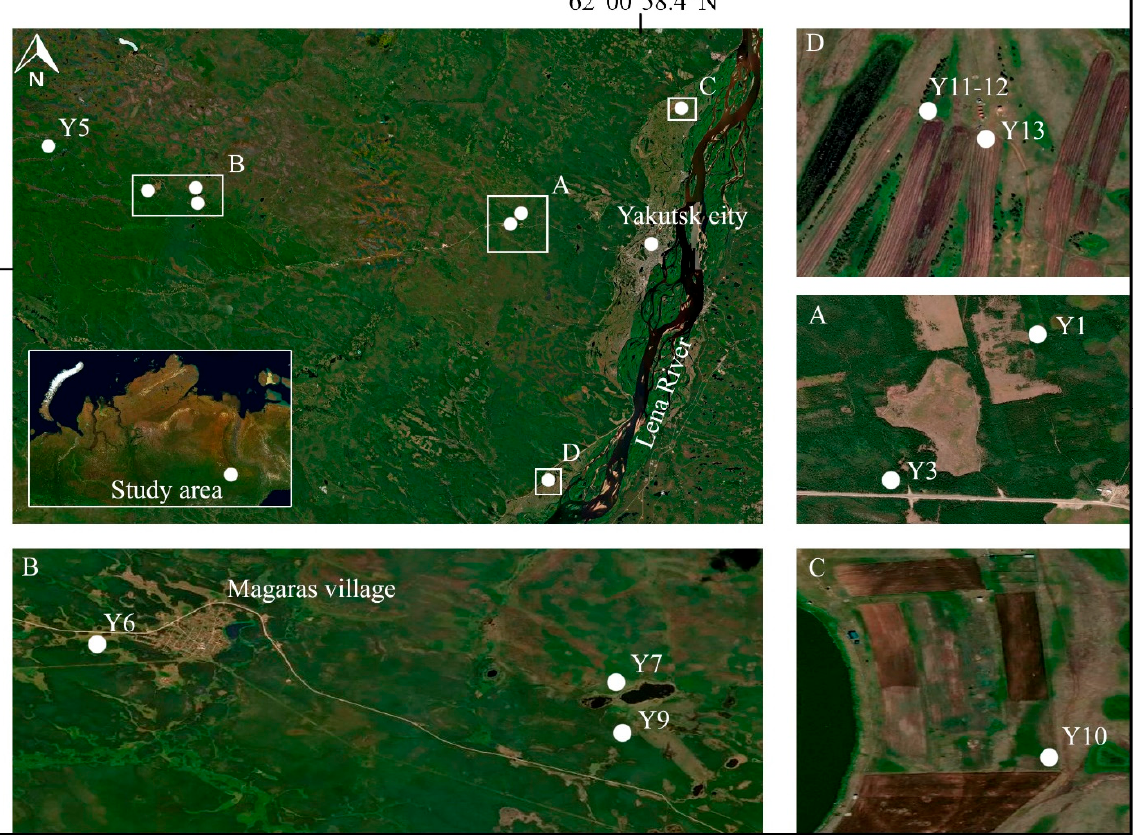
Figure 1. Study area of fallow, pyrogenic and arable soils in the vicinity of Yakutsk ( A – D ). During the study, powerful fires acted in the region, and soils were also selected in areas that were exposed to fire in order to analyze the effect of ground fires on the microstructure of the soil profile. The main criterion in selecting research objects was the coverage of different areas exposed to agriculture in the past and present times. Thus, Y1 is a fallow soil, on which zonal processes of soil formation have been taking place for a long time. The background object, Y3, which has not been exposed to anthropogenic load, was chosen for this site. To study the process of influence of forest fires on micromorphological characteristics of soil, we studied the soil subjected to wildfire (Y5). Near Magaras village, three objects were studied: soil used for cattle grazing (Y6), soil used for haying (Y7), as well as background soil (Y9). To study the micromorphological characteristics of arable soils, we selected several sites in the north and south of Yakutsk (Y10–13). The upper soil horizons, in which the most active soil-forming processes take place, as well as the underlying horizons, were mainly selected as a comparison and for analysis of soil-forming